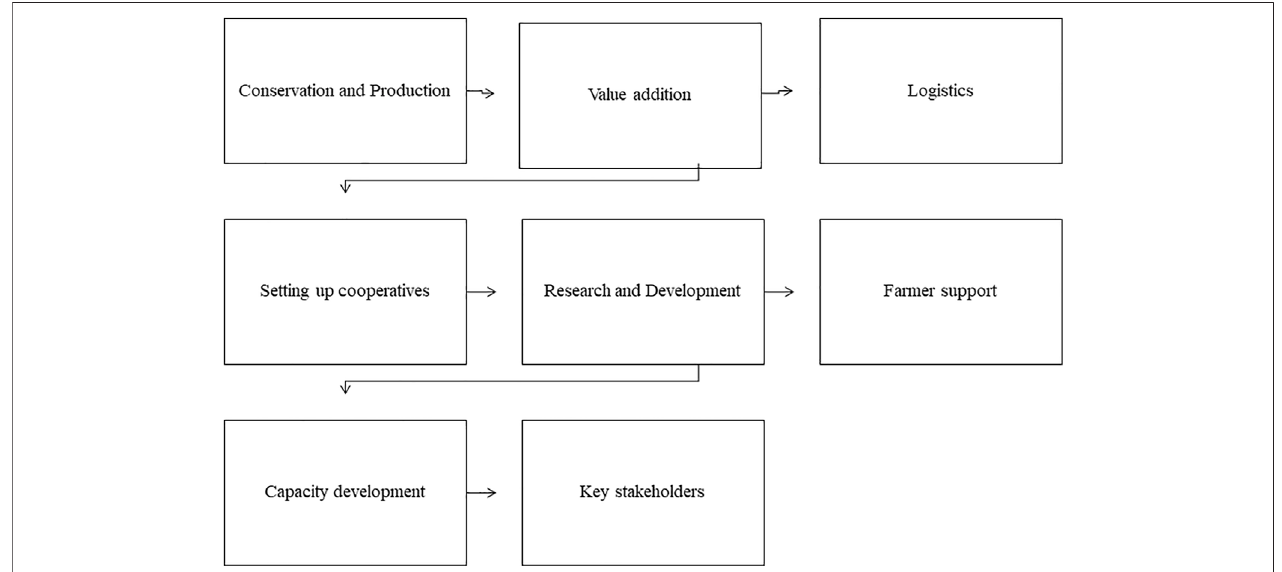
FIGURE 6 | Production strategy for neglected and underutilised functional medicinal